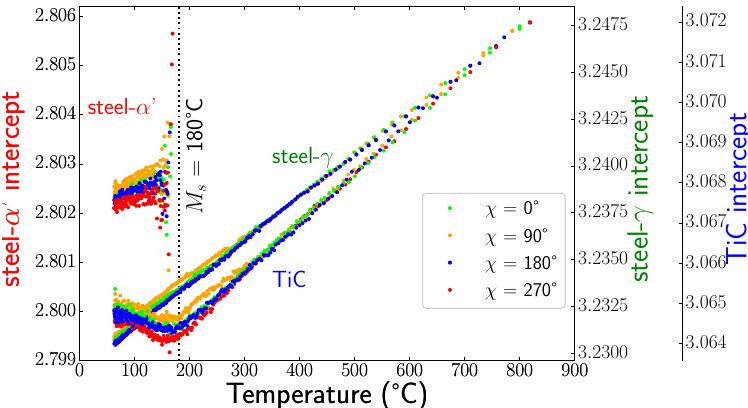
Figure 12. Evolution of the intercepts of the sin 2 Ψ curves versus temperature for different χ angle for steel- γ phase, TiC, and steel- α (cid:48)